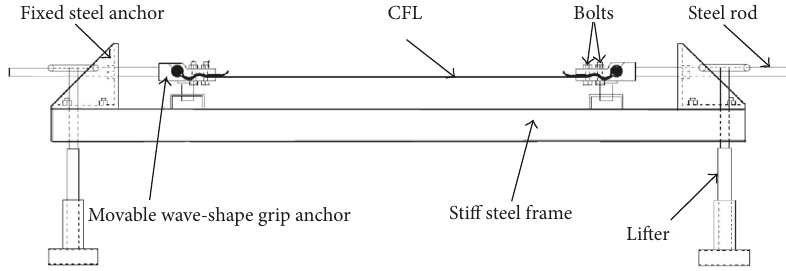
Figure 2: Bed of the prestressing system.